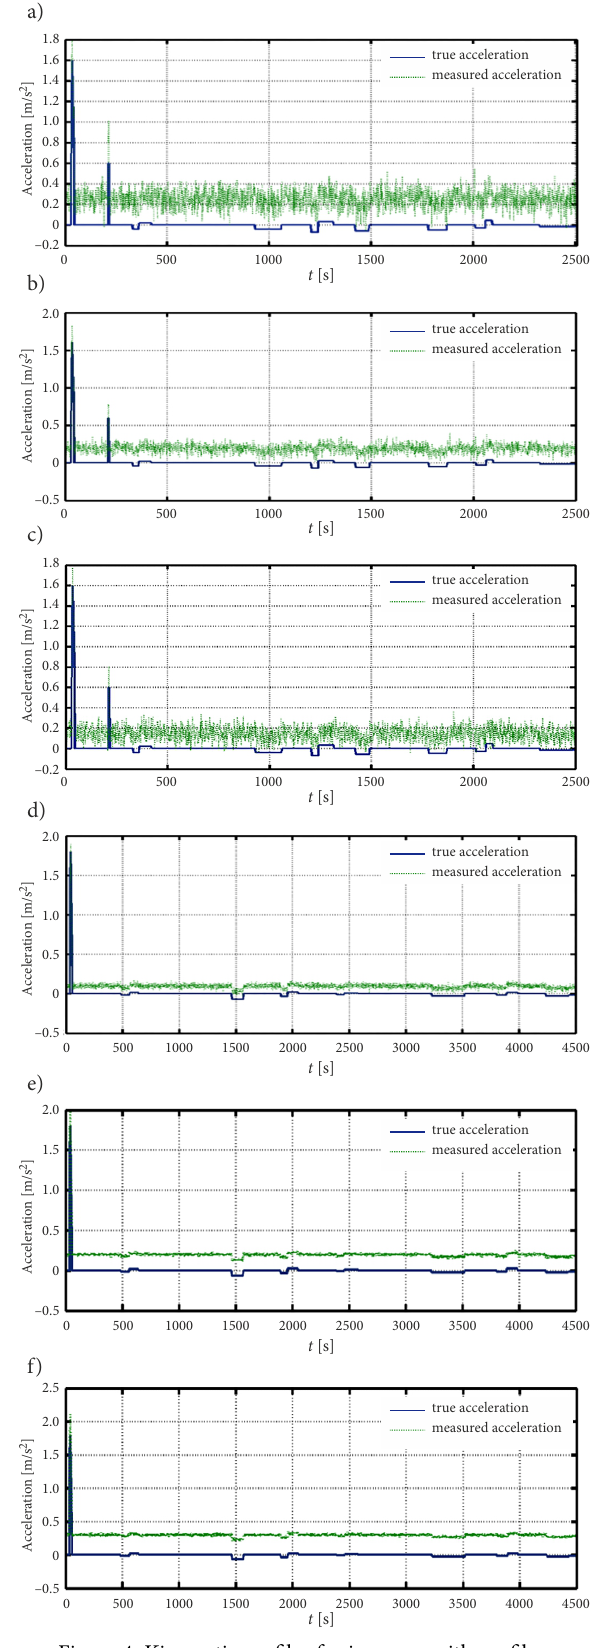
Figure 4. Kinematic profiles for journeys with profiles: a – Journey-A with Profile-1; b – Journey-A with Profile-23; c – Journey-A with Profile-3; d – Journey-B with Profile-4; e – Journey-B with Profile-5; f – Journey-B with